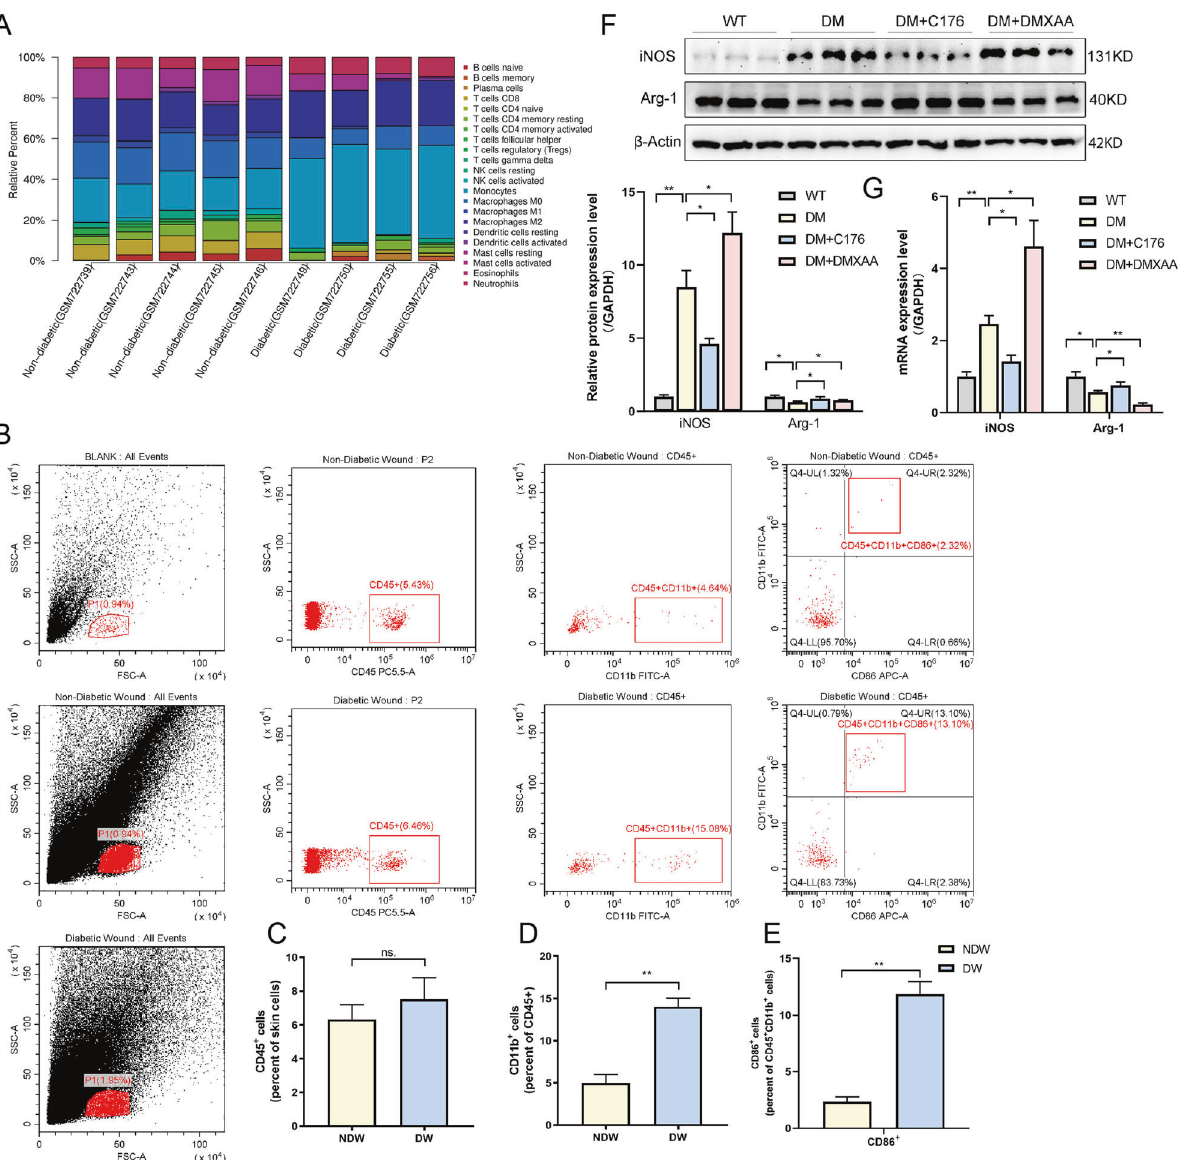
Fig. 5 STING activation promotes M1 polarization of macrophages in DW healing. A Differential immune cell in fi ltration patterns between normal and diabetic tissue microenvironments were performed using GEO microarrays. B Wound leukocytes were isolated for fl ow cytometry and scatter plots, as well as those gated on wound total leukocytes (CD45), are shown. C Percentage of CD45 + cells in total wound homogenate in NDW and DW. D Percentage of CD11b + cells in total wound leukocytes (CD45 + cells) in NDW and DW. E Percentage of CD86 + cells in total wound macrophages (CD45 + CD11b + cells) in NDW and DW. Data were represented as mean ± SD from at least 3 independent experiments ( n = 3 patients per group and experiment). F Wound lysates (at days 7 after trauma) of all groups (indicated at the top of each lane) were examined for iNOS and Arg-1 using western blot analysis. Blots are quanti fi ed using bar graphs. G Wound mRNA (at days 7 after trauma) levels were examined using RT-qPCR. For all bar graphs, data were represented as mean ± SD ( n = 5). * P < 0.05, ** P < 0.01 and *** P < 0.001, NDW vs DW (in C – E ), WT vs DM, DM vs DM + DMXAA, DM vs DM + C176 (in F – G